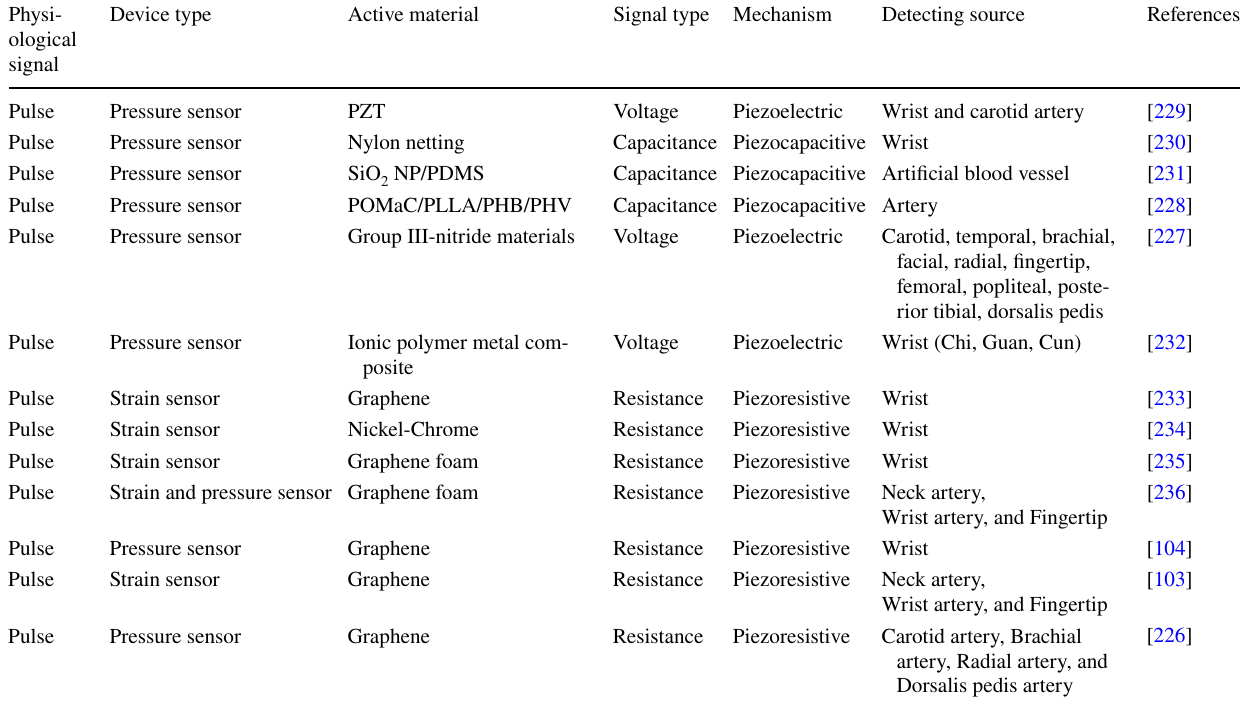
Table 1 Typical soft pulse sensor Physi- ological